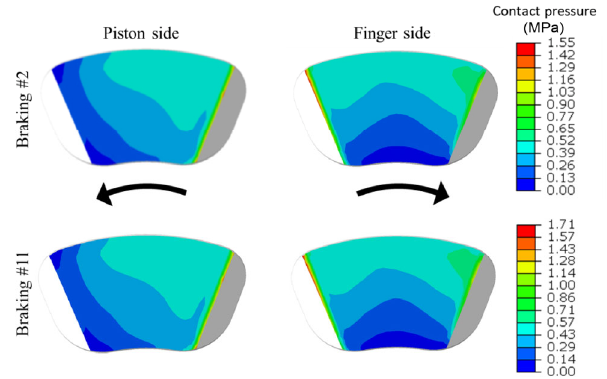
Fig. 6 Contact pressure of braking #2 and #11 in Table 2. Arrows show the disc sliding